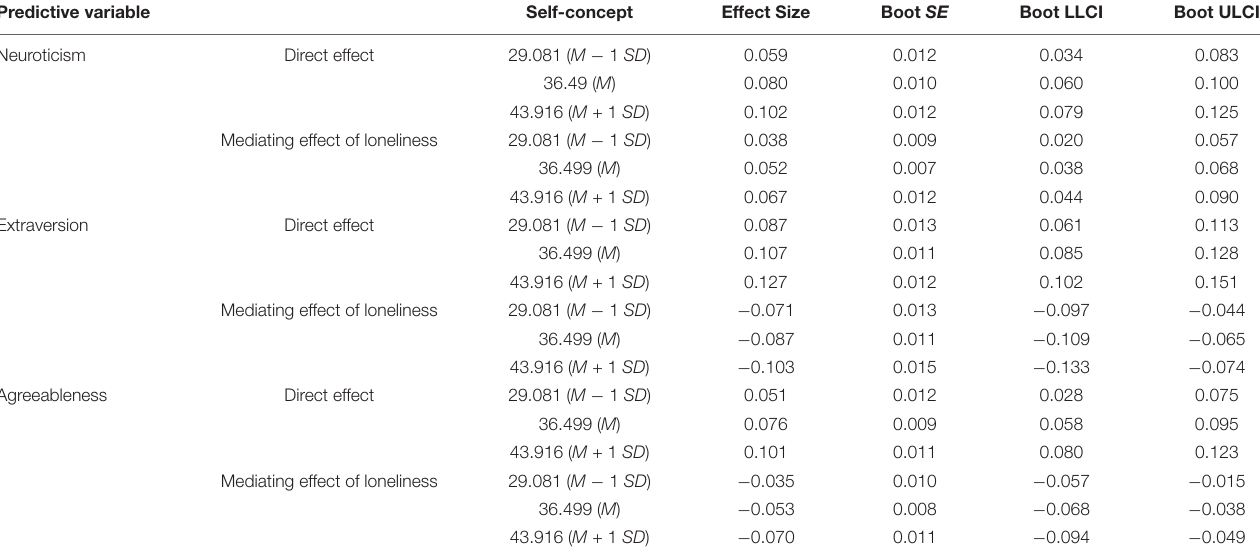
TABLE 5 | Direct and mediating effects for different levels of self-concept.